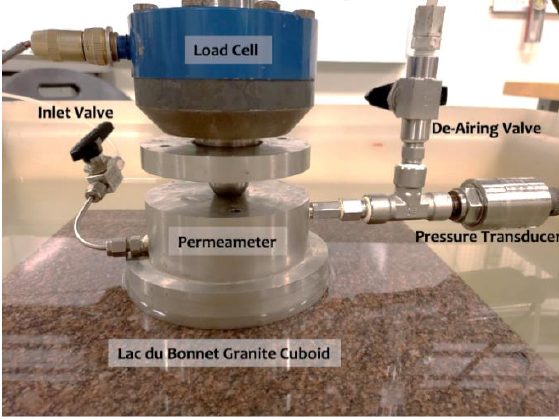
Figure 5. A schematic of the experimental facility.